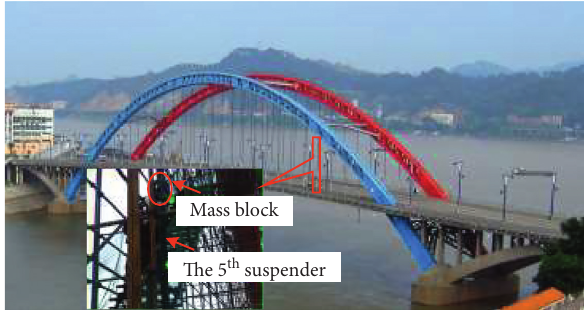
Figure 9: Yuanjiang